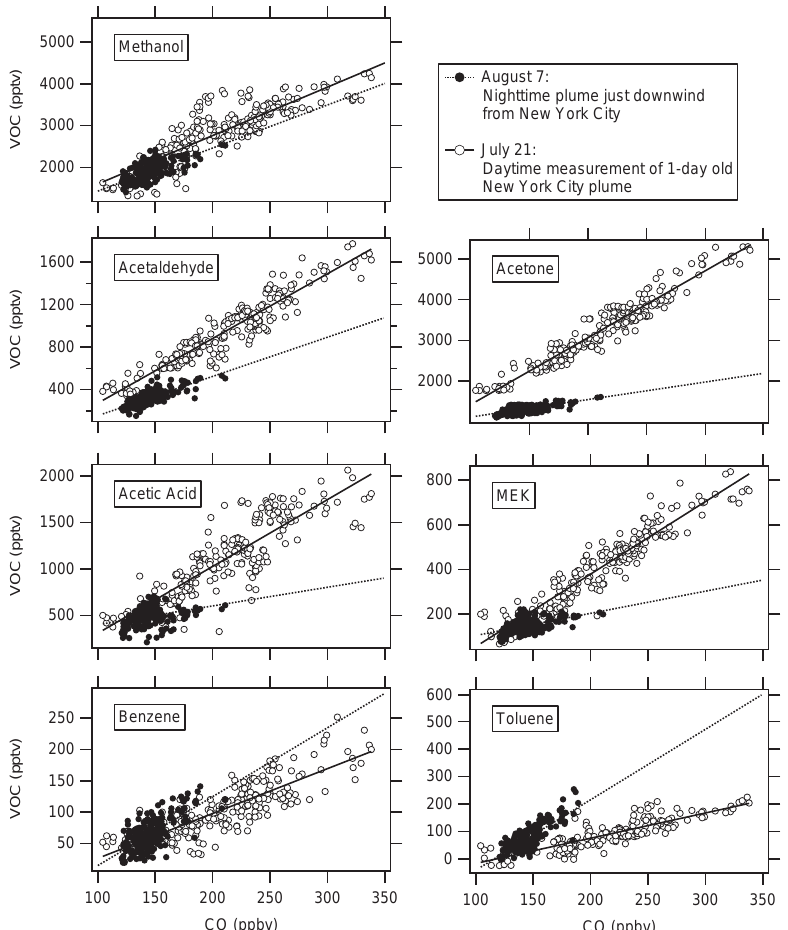
Fig. 4. Scatter plots of VOCs versus CO for the flights from 7 August, during which the outflow from New York City was sampled at night, and 21 July, after 1 day of